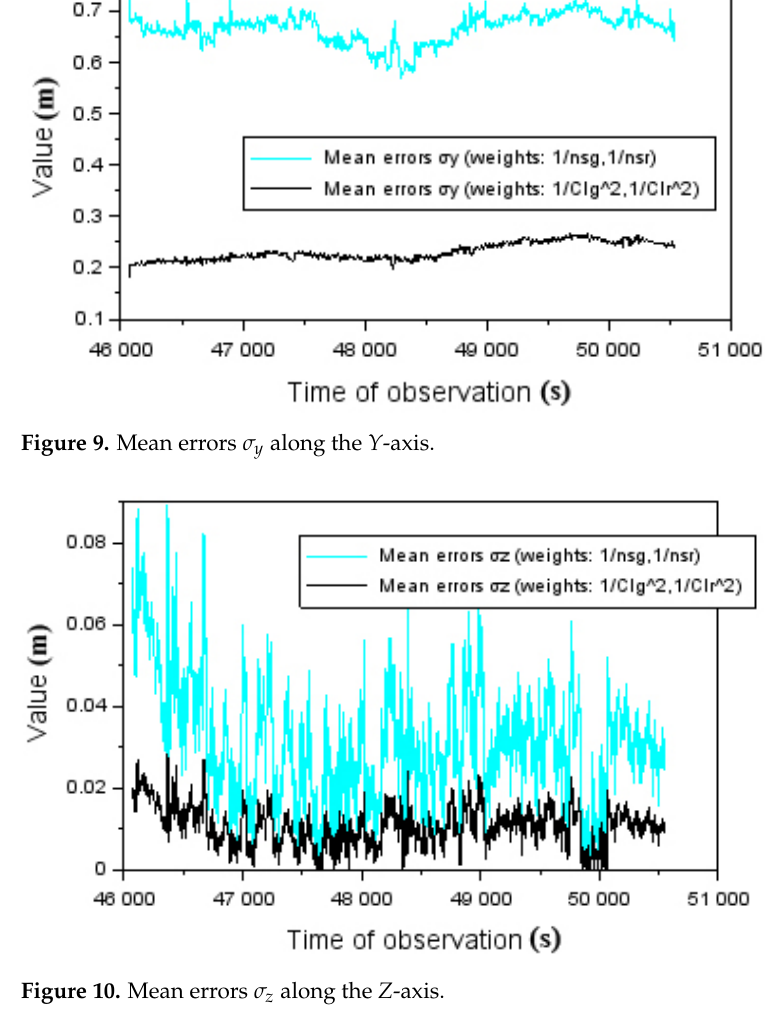
Figure 10. Mean errors